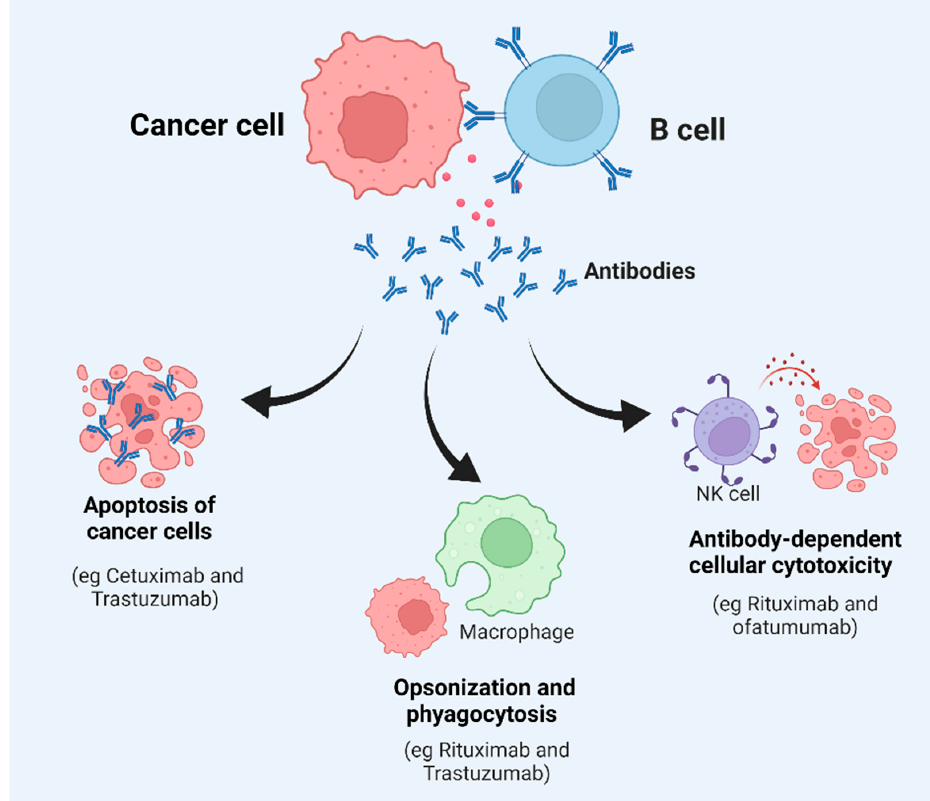
Figure 2. Key factors affecting B-cell function and tumor survival. Once a B cell interacts with tumor cells, it can generate different types of responses, including the secretion of antibodies. This can result in apoptosis, phagocytosis, opsonization, or direct killing of the target cancerous cells or tumors.